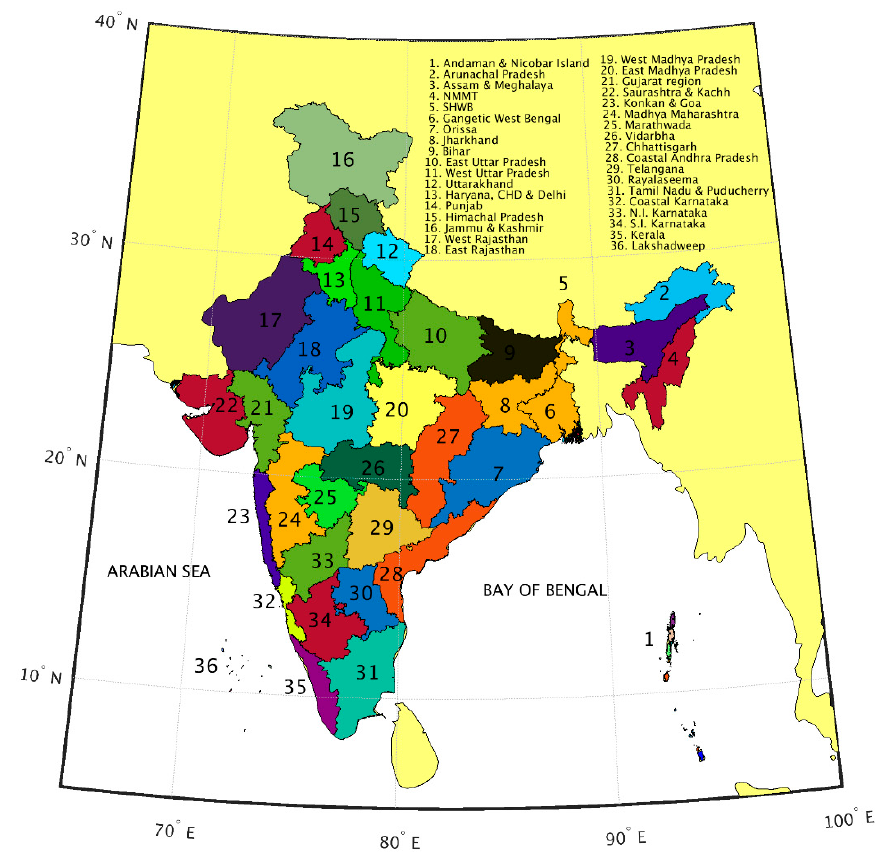
Figure 1. The outline of the 36 meteorological sub-divisions of